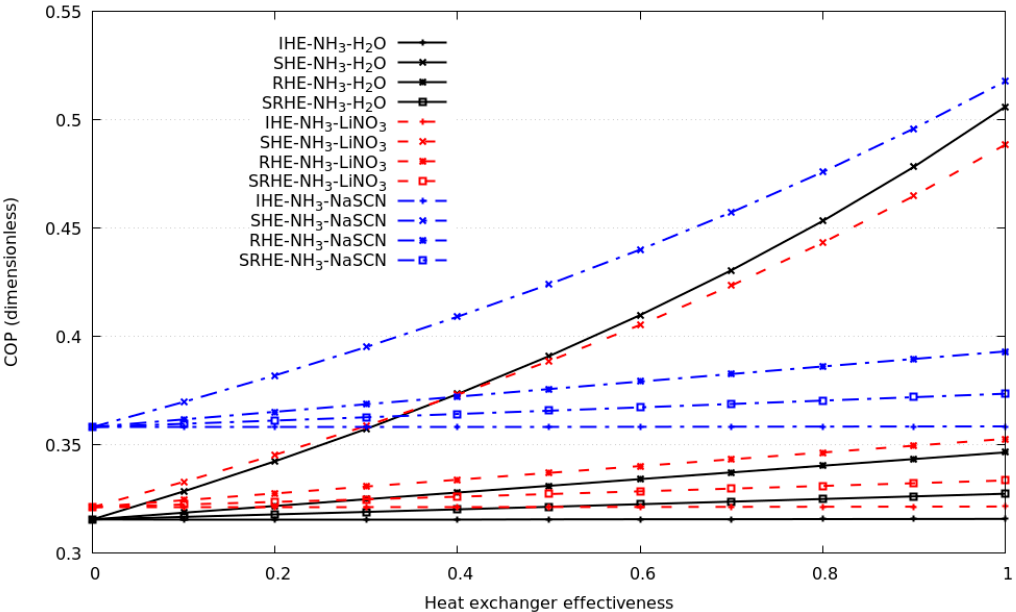
Figure 5. The coe ffi cient of performance against heat exchanger e ff ectiveness for each of the economizers Figure 5. The coefficient of performance against heat exchanger effectiveness for each of the considering all solutions and R134a as working economizers considering all solutions and R134a as working fluid.